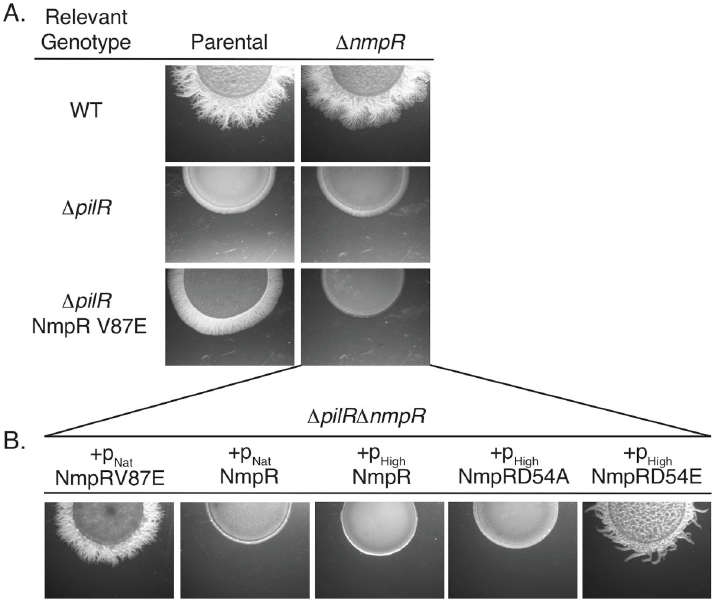
Fig 3. The NmpR V87E suppressor strain has a gain-of-function mutation. (A) In-frame nmpR deletions were constructed in the indicated strains and assayed for motility on 0.5% agar. All images depicted are after two days of motility. (B) Single copy complementation vectors were integrated at the Mx9 phage attB site and resulting strains assayed for motility. The p Nat = 585 bp upstream of mxan_4236 (See Fig 2A) and p High = 623 bp upstream of mxan_4894 , groES [43, 44] (See S1 Fig). D54A is an unphosphorylatable form of NmpR and D54E is a phosphomimetic.